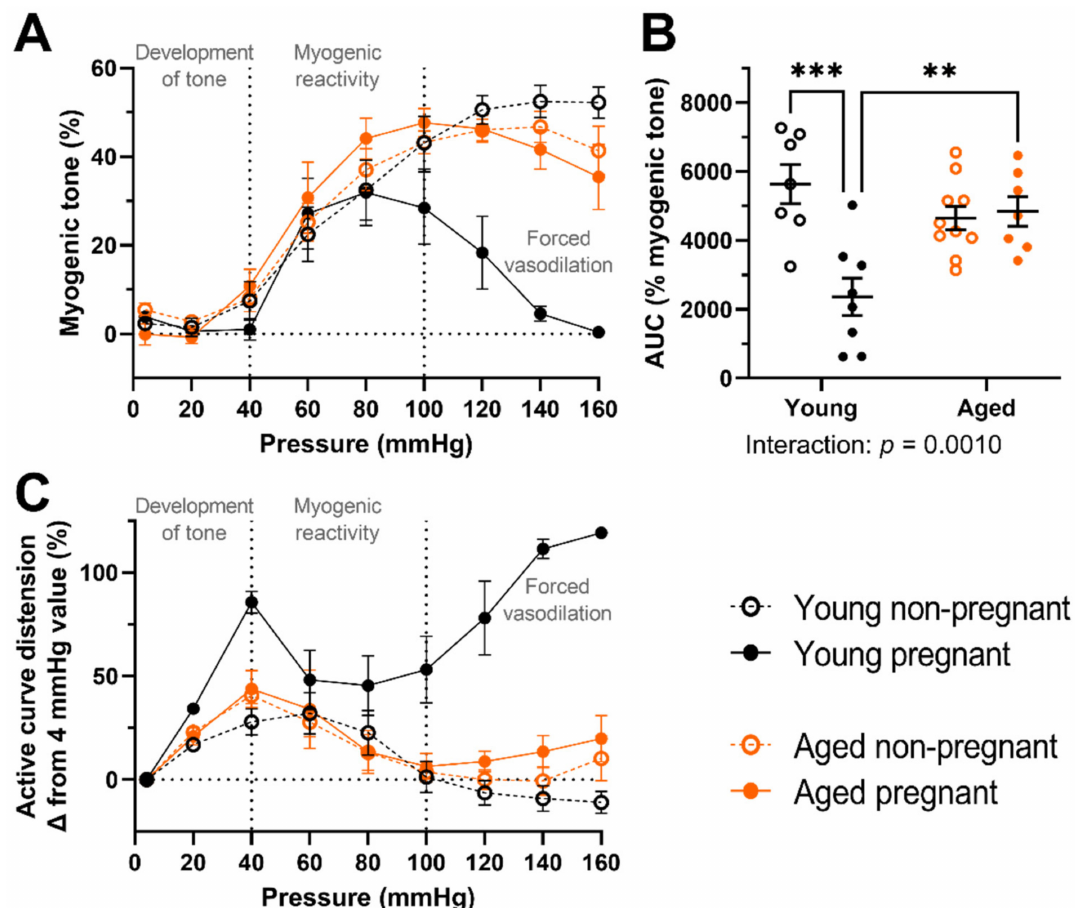
Figure 2. Active pressure myography outcomes for main uterine arteries from young (black) and aged (orange) nonpregnant (open circles) and pregnant (GD 20; closed circles) rats. ( A ) Percentage myogenic tone calculated from the intraluminal diameter (ID) measures using the equation: percentage myogenic tone = ((ID passive − ID active )/ID passive ) × 100, where ID active is the intraluminal diameter when assessed in phosphate-buffered saline solution with calcium present to enable smooth muscle cell contraction, and ID passive is the intraluminal diameter when assessed in a calcium-free solution containing papaverine to prevent smooth muscle contraction; ( B ) Percentage myogenic tone area under the curve (AUC), calculated from the entire pressure curve range of 4–160 mmHg; ( C ) The active pressure myography curve data, now presented as a percentage difference in ID from baseline (4 mmHg). Data presented as mean ± SEM; n = 7–10 rats/group. Percentage myogenic tone AUC was compared using a two-way ANOVA (age vs. pregnancy status) followed by Sidak’s post hoc test. ** p < 0.01; *** p <